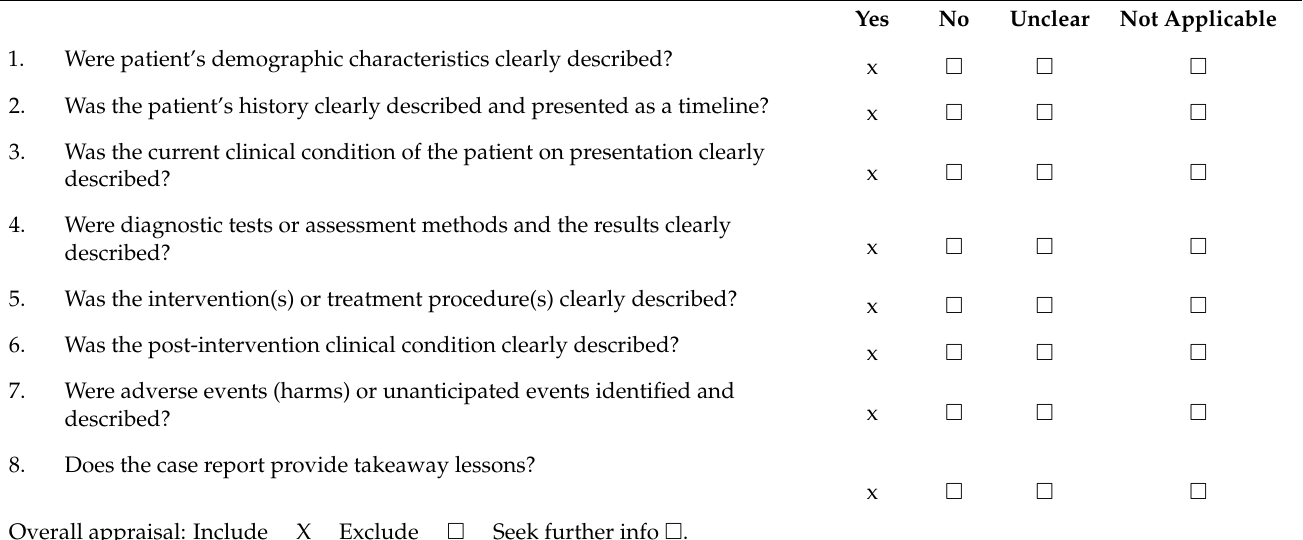
Table A5. JBI Critical Appraisal Checklist for case reports—Davenport et al. (2018). Citation: Davenport, M.H.; Steinback, C.D.; Borle, K.J.; Matenchuk, B.A.; Vanden Berg, E.R.; de Freitas, E.M.; Linares, A.M.; O’Halloran, K.D.; Sherpa, M.T.; Day, T.A. Extreme Pregnancy: Maternal Physical Activity at Everest Base Camp. J. Appl. Physiol. 2018 , 125 , 580.